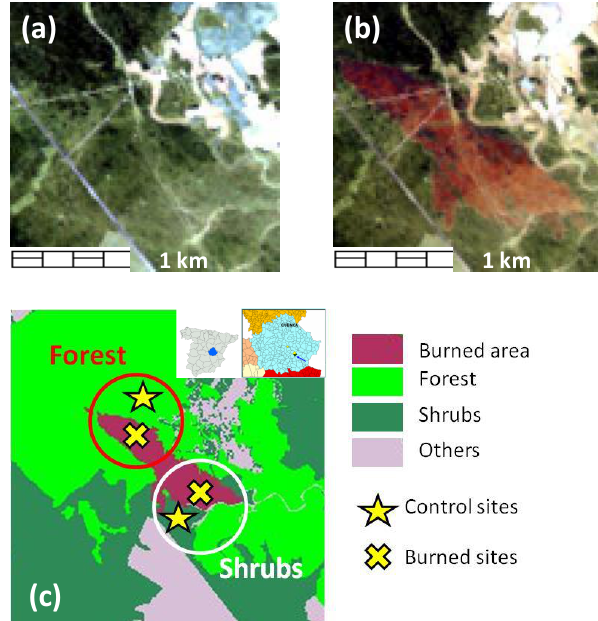
Figure 2. L7-ETM+ false color compositions (7,5,3) of the study site before ( a ) and after the fire ( b ) for 8 June and 26 July 2001, respectively. Land use map after the fire ( c ) with indication of the test sites [22]. Table 1 . Forest stands variables (mean and standard error) for both the Mediterranean maritime pine (PPr) and the holm oak (Qi), in 2010, for the unburnt site (Forest_c area) and